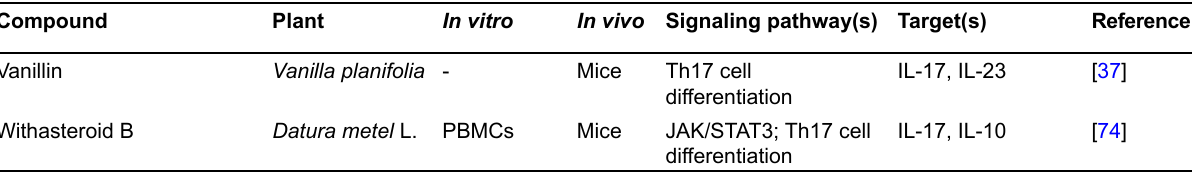
Table 2. The effects of natural compounds on psoriasis ( continued ) Compound